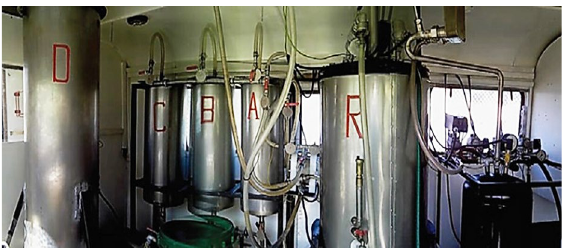
Fig. 2. A panoramic view of a mobile diesel production plant, built on a chassis of a Star 266 vehicle – the transesterification reactor (R) with the post-reaction mixture separators (A, B, C) (Piętak et. al.